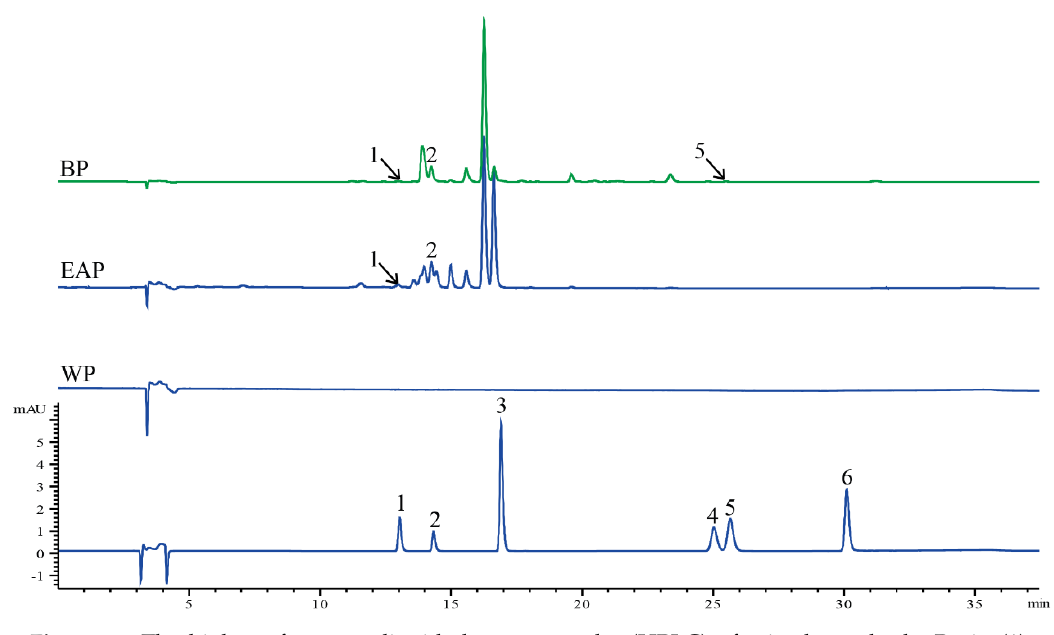
Figure 1. The high performance liquid chromatography (HPLC) of mixed standard. Rutin (1), luteolin-4 (cid:48) - O -glucoside (2), apigenin-7-O-glucoside (3), luteolin (4), quercetin (5), and apigenin (6). Table 2. The phenolic compositions of three phases.